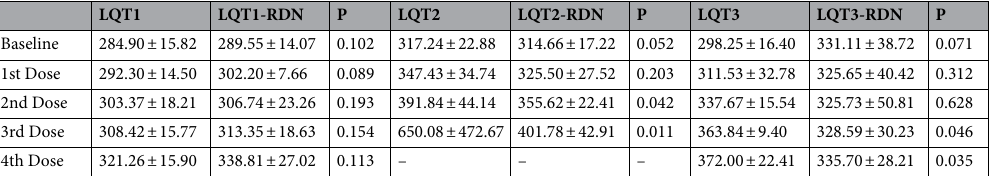
Table 2. The QTc interval measurement (ms) from baseline to the sequentially increased doses of all LQTS subtype induction (LQTS induction drugs and doses are described in the “Methods”